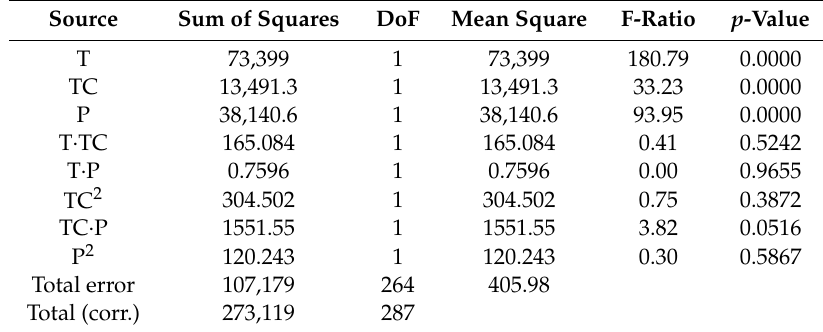
sawdust briquettes.